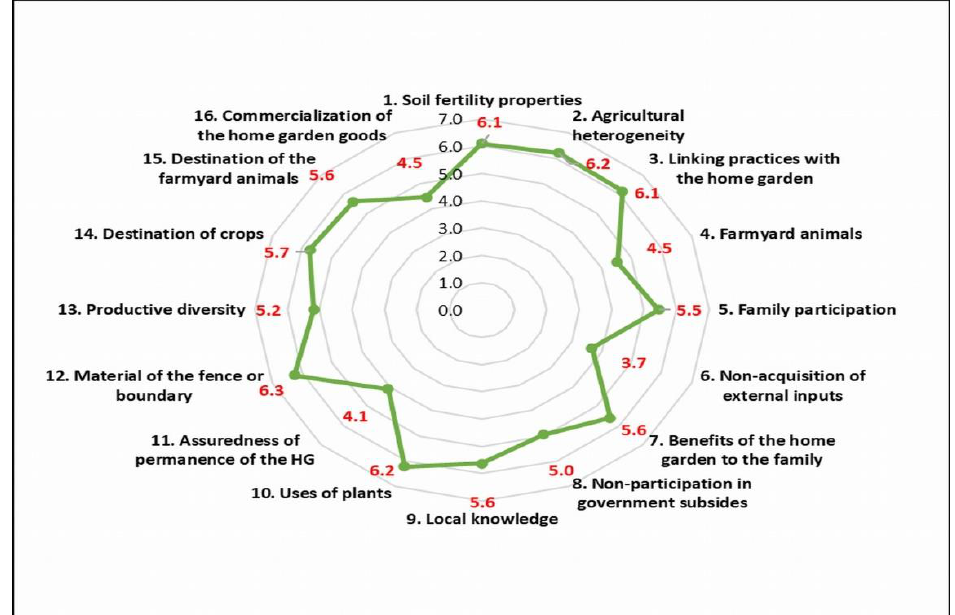
Figure 8. Average value per indicator of home gardens with super strong sustainability.